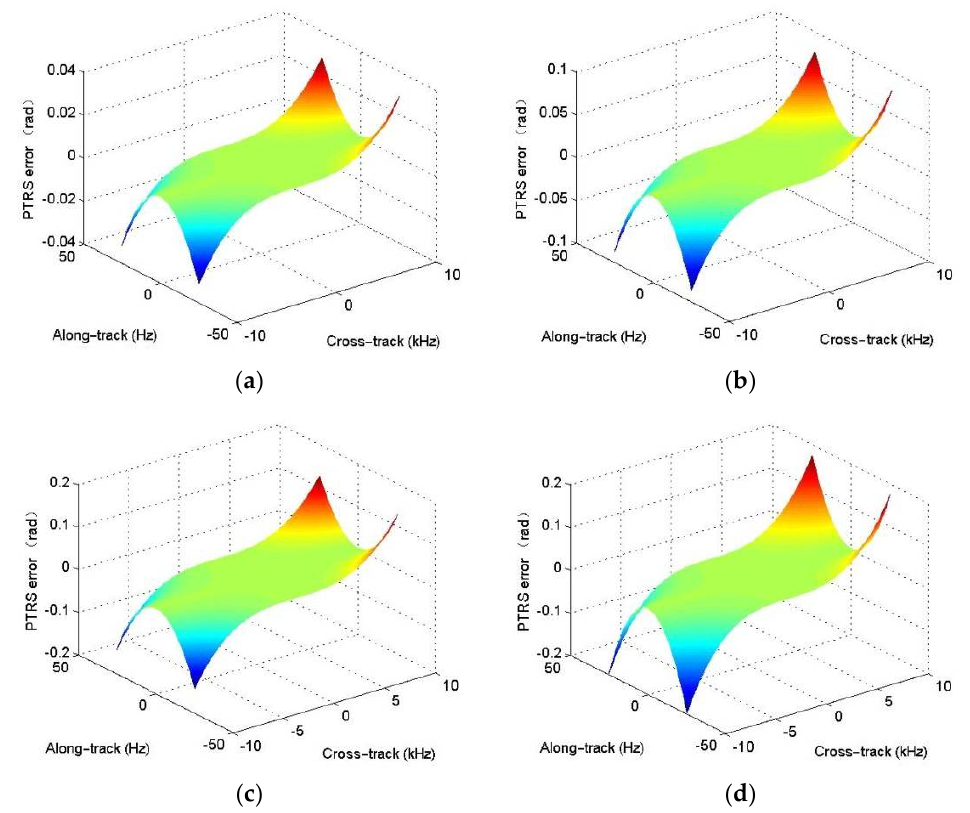
Figure 6. PTRS error for the first transmitter/receiver pair when the system works with a narrow- bandwidth. ( a ) r = 40 m; ( b ) r = 110 m; ( c ) r = 180 m; ( d ) r = 250